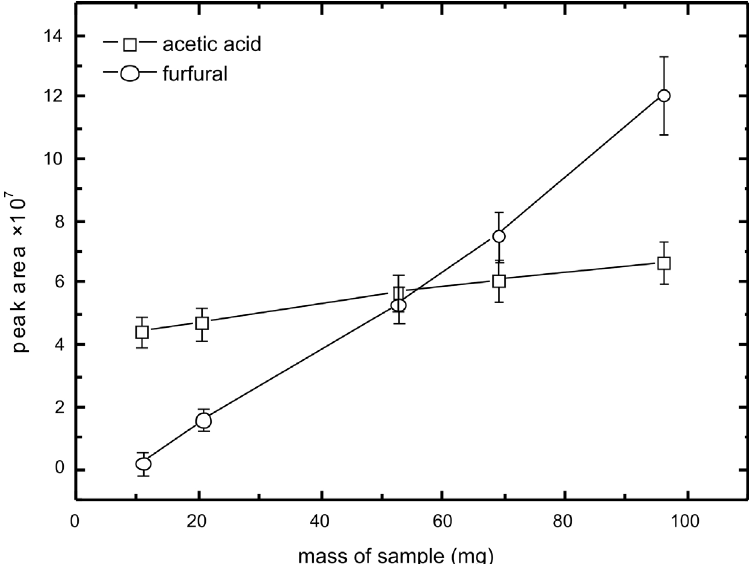
Figure 1. Comparison of chromatographic peak areas for acetic acid and furfural emitted by sample no. 14 in a glass vial at 80 o C in 18 h. Conditions of extraction using SPME fibre: 40 o C, 1 h. The intervals denote standard deviation of triplicate